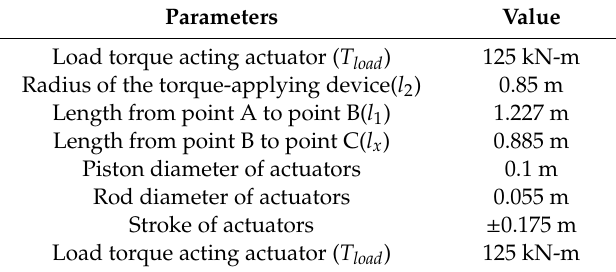
Figure 13. Torque meter installed on the test rig.